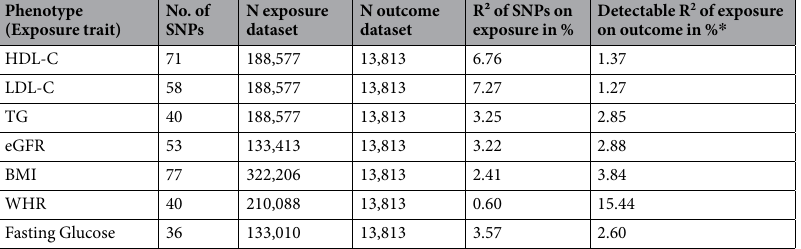
Table 1. Strength of instrumental variables used for the MR analyses: Explained variance (R²) of SNPs on the different exposure traits and detectable causal explained variance (R 2 ) of the exposure traits on apoA-IV as